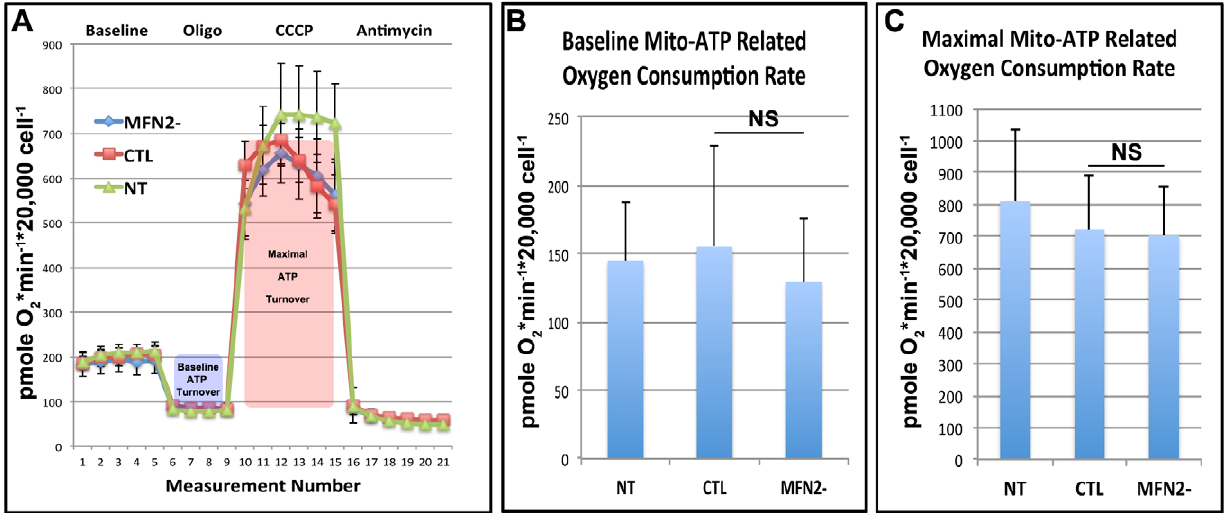
Figure 7. Effect of MFN2 deficiency on oxygen consumption rate (OCR) profile. ( A ) Serial measurements of OCR at 7 minute intervals (‘‘measurement number’’) in MFN2-deficienct (MFN2-) and control (empty virus transduced ‘‘CTL’’ or non-transduced; ‘‘NT’’ ) cells at baseline and after the addition of oligomyin, CCCP, or antimycin. Results of a single representative study with five replicate OCR measurements and their SD is shown. ( B ) OCR due to baseline ATP turnover rate ( baseline minus oligomycin OCR ) in each group expressed as the mean and SD of 3 separate experiments; NS ‘‘non significant; P . 0.05. ( C ) OCR due to maximal mitochondrial ATP turnover rate ( CCCP stimulated minus oligomycin OCR ) in each group expressed as the mean and SD of 3 separate experiments; NS ‘‘non significant; P . 0.05.